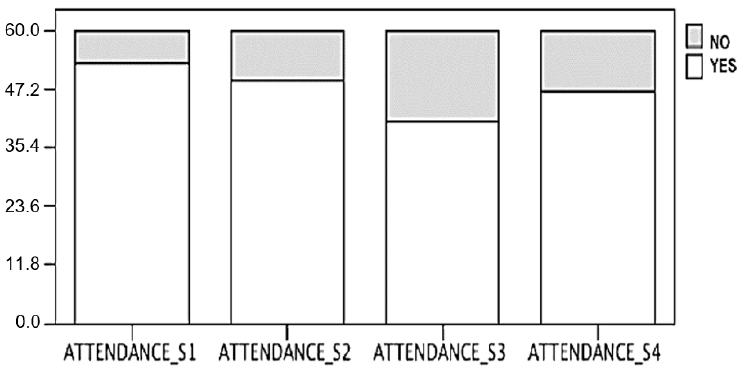
Figure 2. Attendance of the cycling intervention.